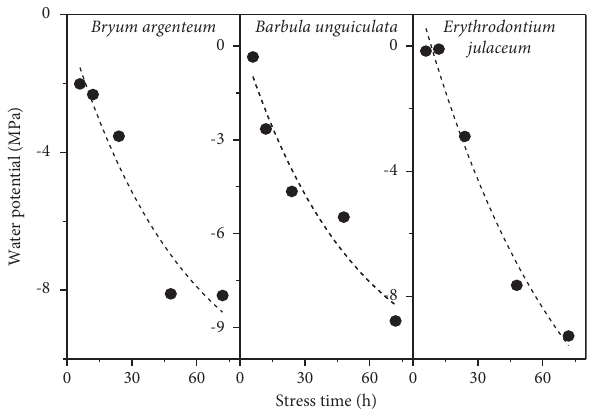
Figure 1: Effect of drought stress on water potential in three epilithic mosses.